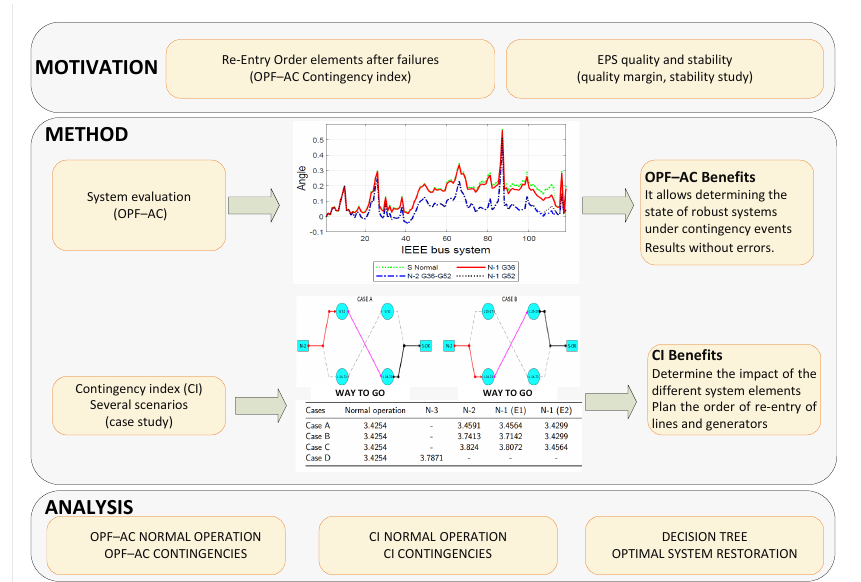
Figure 1. Proposed solution